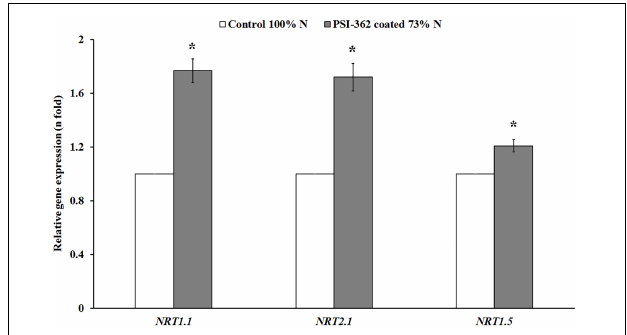
FIGURE 4 | Relative expression of major nitrate transporter genes in spring barley root tissue (cv. Gangway). The effect of PSI-362 coated CAN + S fertilizer on the relative expression of HvNRT1.1 , HvNRT2.1 , and HvNRT1.5 in root tissue 22 days after application in field 1 (73% N fertilizer rate). Results are expressed as the relative log 2 fold-change with respect to the HvUBC9 gene expression level and benchmarked against untreated plants growing under 100% N fertilizer rate. The error bars represent SE and means followed by asterisk within the same gene and field indicate significant differences between control and the PSI-362 treatment based on t -test at p ≤ 0.05. Number of biological replicates ( n =